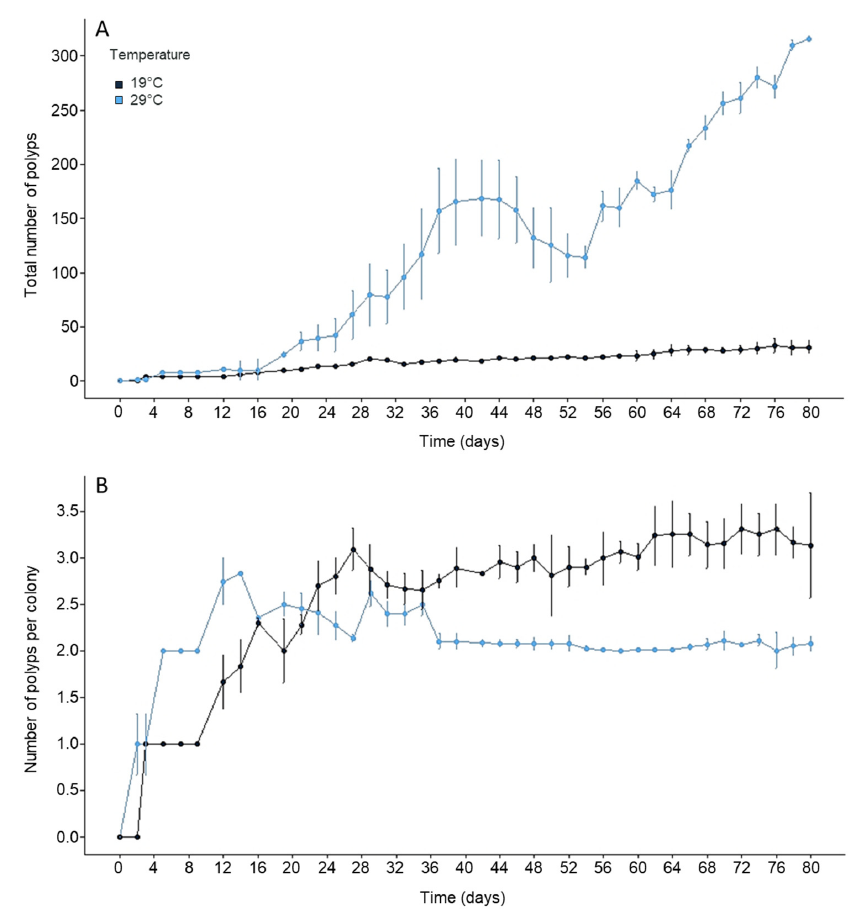
Figure 1. ( A ) Development of the total number of Craspedacusta sowerbii polyps and ( B ) mean (± standard deviation) number of polyps per colony at 19 and 29 °C, respectively.